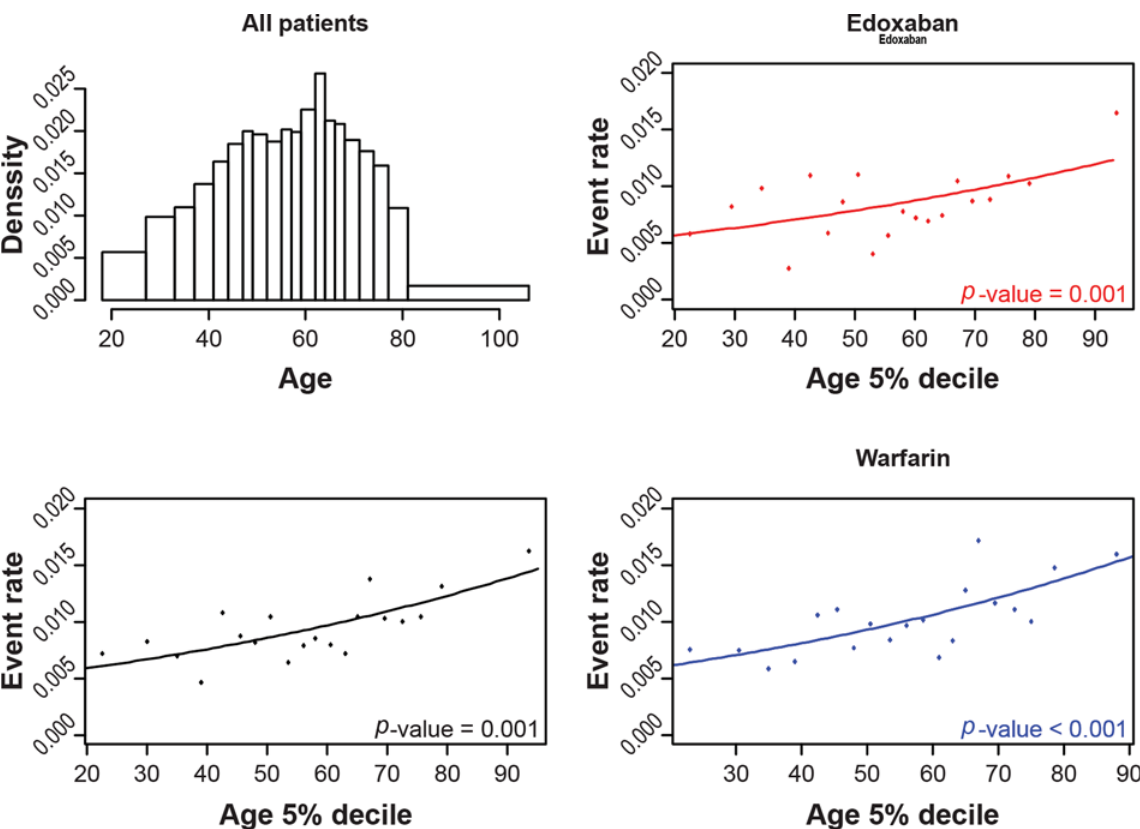
Fig. 4 The relationship between clinically relevant bleeding and age, overall and by treatment